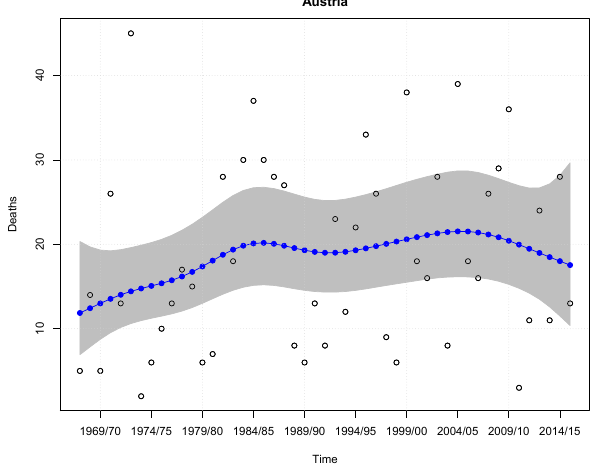
Figure 2. Observed ( ◦ ) and estimated ( fatalities with 90% confidence band (grey) in Austria within